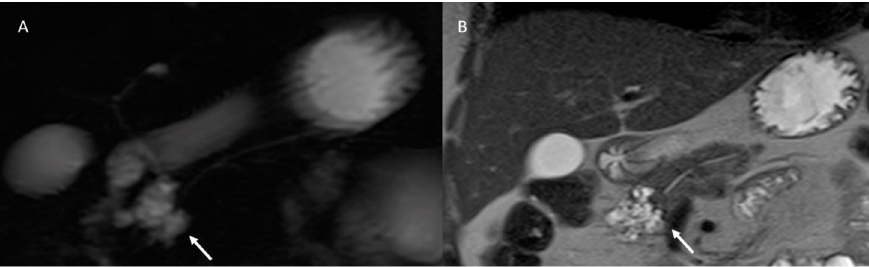
Figure 6. Abbreviated MRI assessment (MRCP: ( A ) and T2-W: ( B ) sequences) of pancreatic cistoad- enoma, which is characterized by multicyclic lesions (arrow).